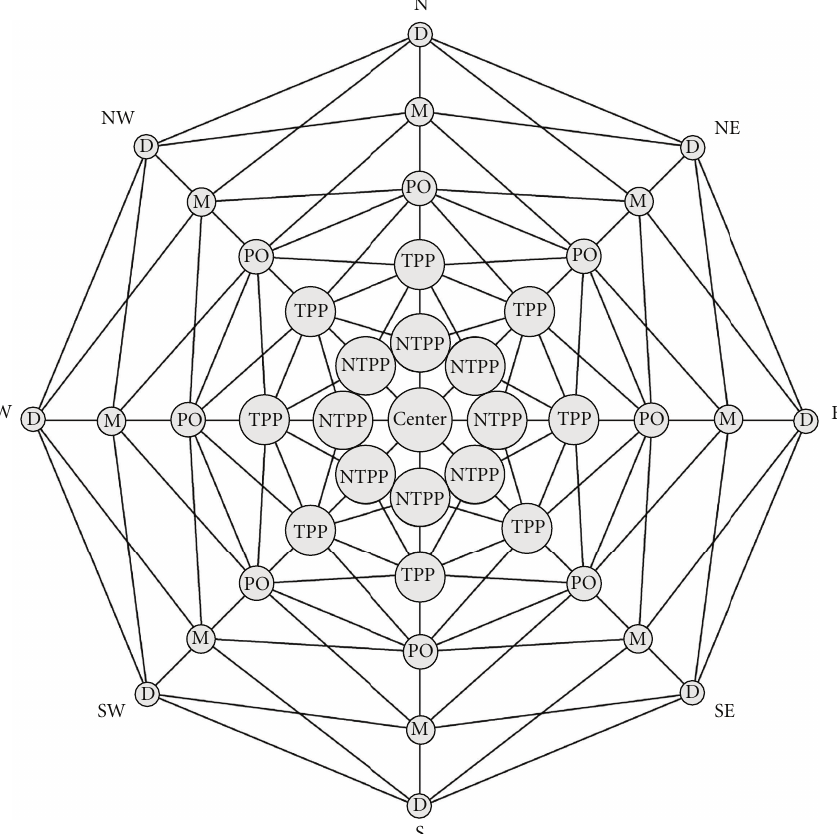
Figure 3: Neighborhood graph in the system of combined topological and directional relations (CTD)